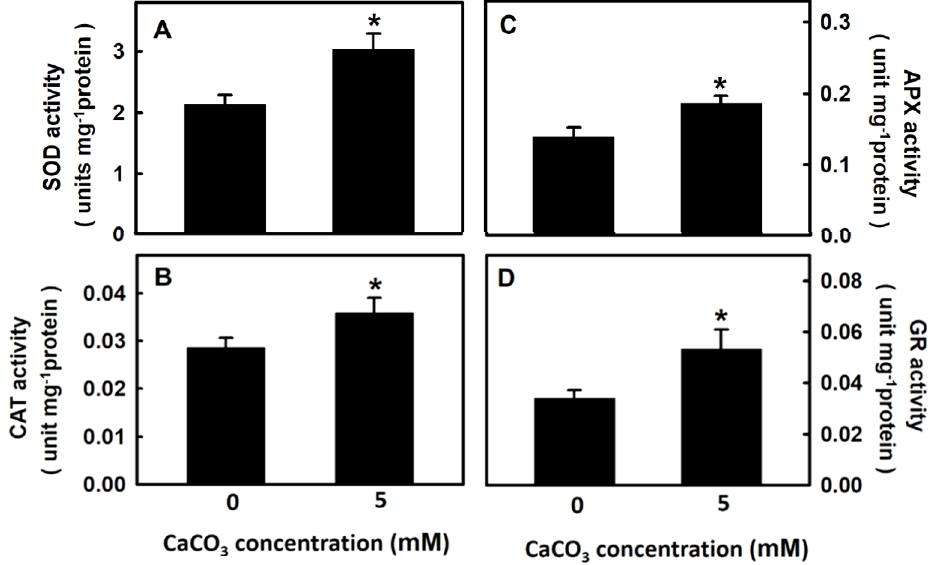
Figure 4. The effect of calcium carbonate on antioxidant enzyme activities of Djulis sprouts. The 7- d-old djulis plants were treated with 5 mM CaCO 3 for 5 days. The SOD ( A ) CAT ( B ) APX ( C ) and GR ( D ) activities of djulis were measured. Bars show means ± SE ( n = 4). * represent values that are significantly different between calcium carbonate concentration 0 mM and 5 mM at p < 0.05.